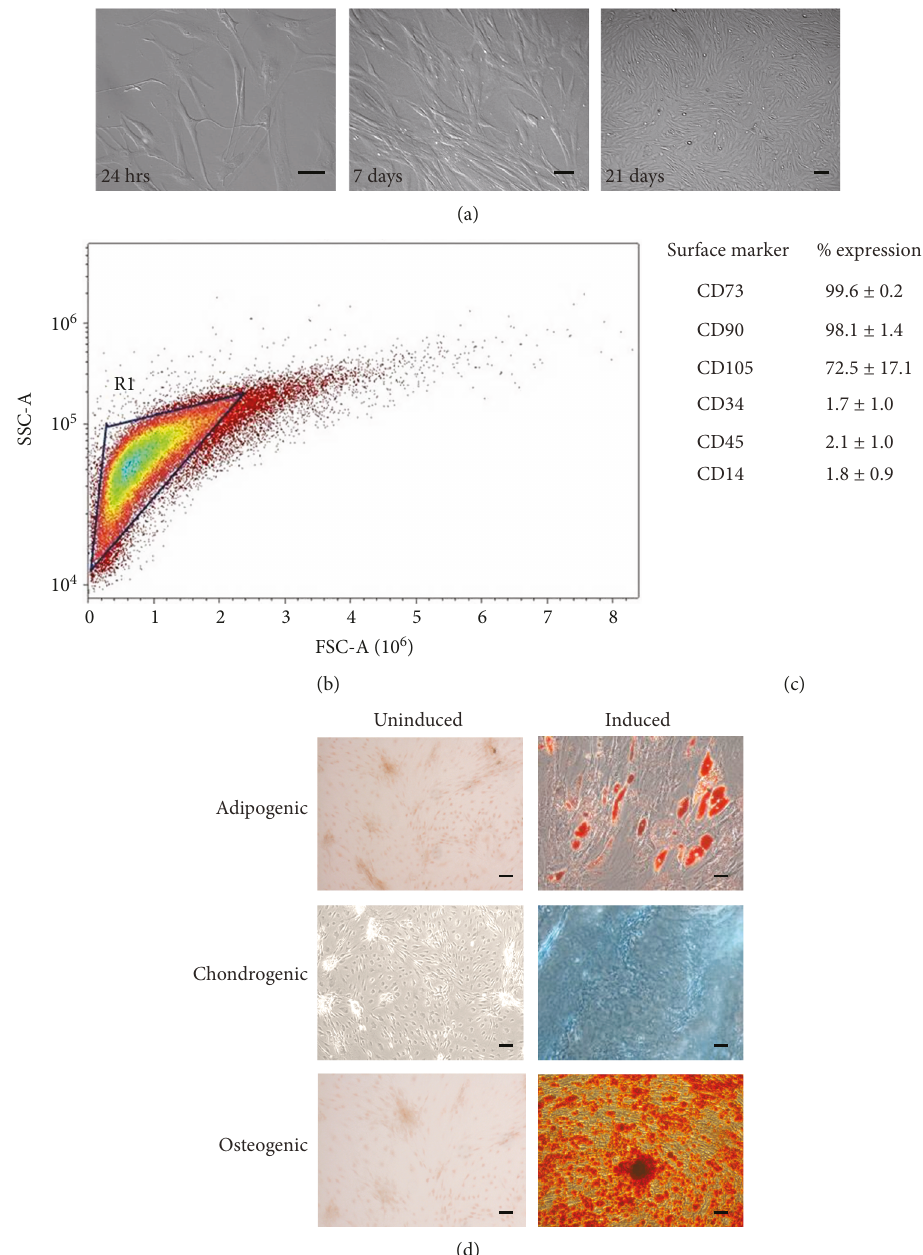
Figure 1: Isolation and characterization of ADSCs from the adipose tissue of Ovis aries . (a) Monolayer of adherent spindle-shaped fi broblastoid cells compatible with undi ff erentiated mesenchymal stem cells. Culture of the adherent cell population at 24 h postisolation. Cells cultured with the DMEM after 7 days. The cell culture reached con fl uence after 21 days (scale bar =80 μ m). (b) Flow cytometry analyses are illustrated. FSC by SSC indicates a homogeneous population in size and granularity. (c) Surface marker expression: the data represent the mean percentage ± standard deviation of 3 independent experiments. (d) Trilineage di ff erentiation of ADSCs into adipocytes, osteoblast, and chondrocytes is shown. Oil red staining of ADSCs induced for adipocyte di ff erentiation. Alcian blue staining of ABMCs induced for chondrocyte di ff erentiation. Osteoblast di ff erentiation visualized using Alizarin red (scale bar =80 μ